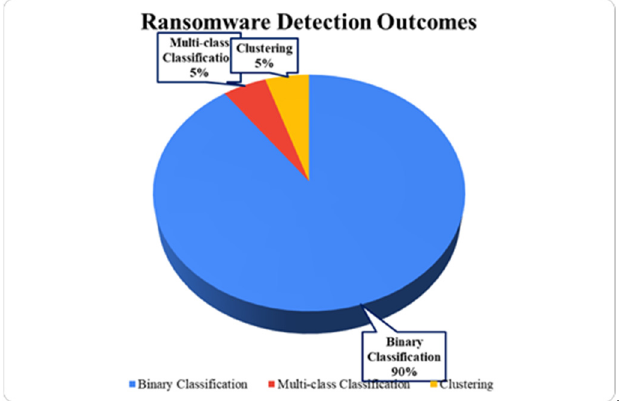
Figure 12. Ransomware detection outcomes.